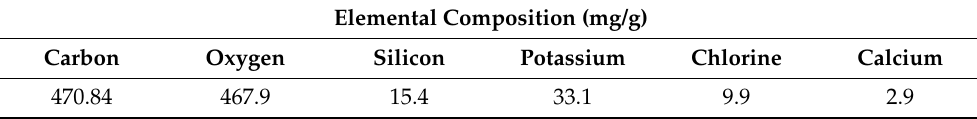
Table 5. Elemental composition and chemical analysis of rice straw (modified from [74]).